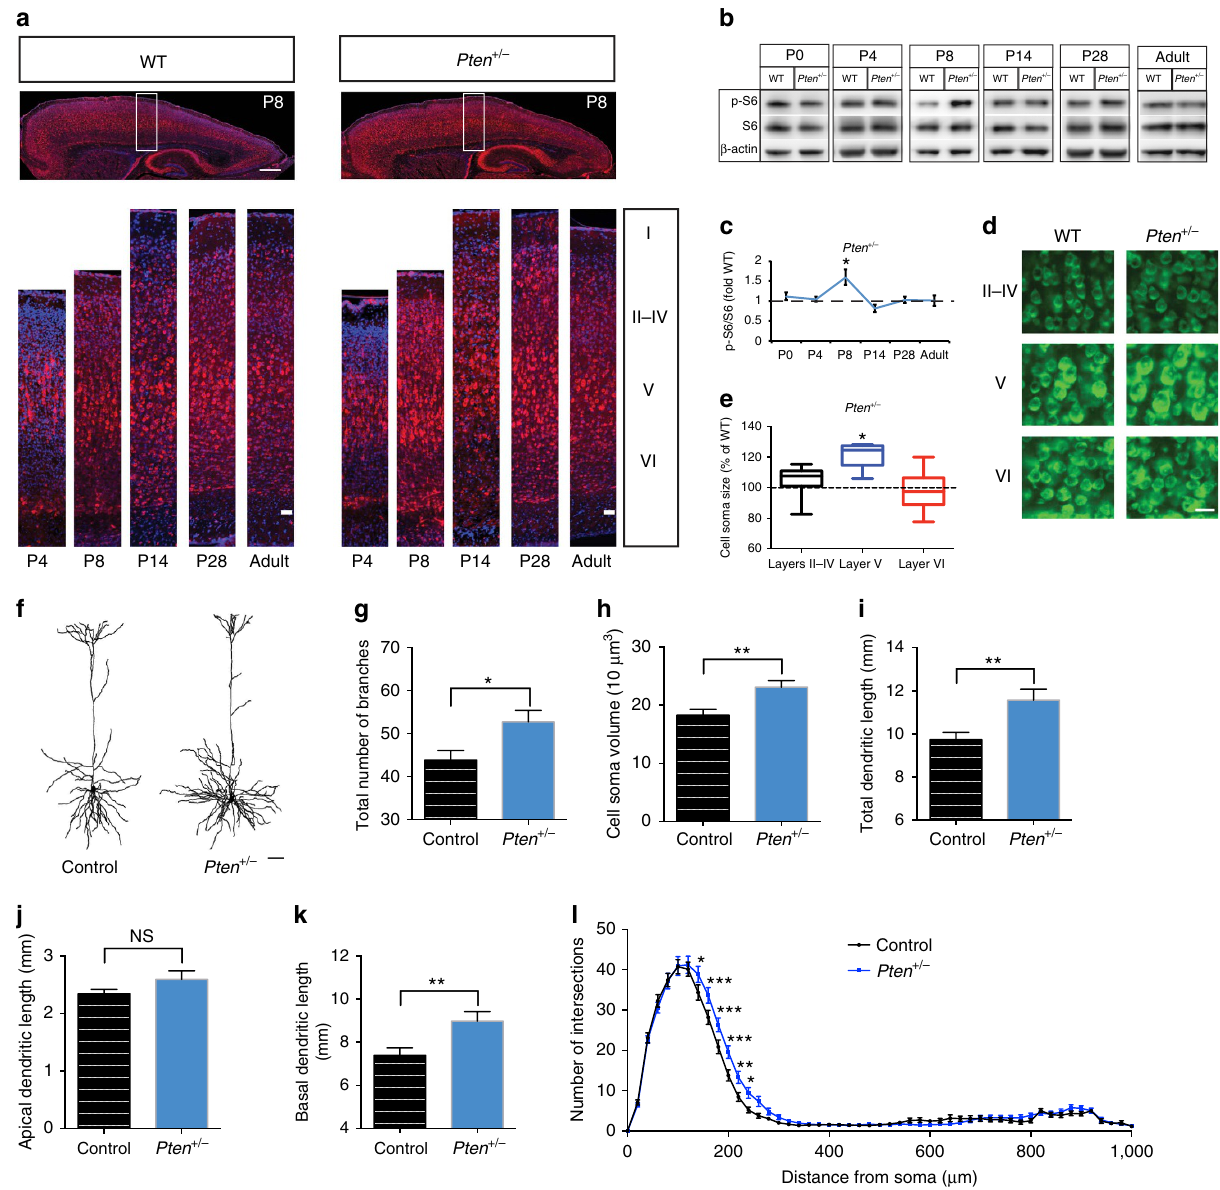
Figure 1 | Characterization of mTORC1 activity and neuronal growth in Pten mutant mice. ( a ) Images showing phospho-S6 (p-S6), a readout for mTORC1 activity, immunostaining in the cerebral cortex of postnatal day 8 (P8) WT and Pten þ / (cid:2) mice. Phospho-S6 (red), DAPI (blue) and scale bar, 500 m m. Representative somatosensory cortex with p-S6 immunostaining in P4, P8, P14, P28, and adult WTand Pten þ / (cid:2) mice. Phospho-S6 (red), DAPI (blue), and scale bar, 50 m m. ( b ) Representative images of western blot for p-S6, total S6 and b -actin in WTand Pten þ / (cid:2) whole cerebral cortex at P0, P4, P8, P14, P28 and adulthood. ( c ) Quantification of p-S6 levels relative to total S6, expressed as fold WT, in the whole cerebral cortex of WT and Pten þ / (cid:2) mice at P0, P4, P8, P14, P28 and adult. Independent-sample t tests were used. * P o 0.05. N ¼ 5 animals per genotype for each time point. ( d ) Representative images of fluorescent Nissl stain in somatosensory cortical layers II–VI of WT and Pten þ / (cid:2) mice at P14. Scale bar, 25 m m. ( e ) Quantification of cell soma size in somatosensory cortical layers II–VI of WT and Pten þ / (cid:2) mice at P14, expressed as per cent of WT. Independent- sample t tests were used. * P o 0.05. N ¼ 6 animals in each genotype. ( f ) Representative images of reconstructed layer V neurons in the somatosensory cortex of P14 Etv1-CreERT2; Ai14 (Control) and Etv1-CreERT2; Ai14; Pten þ / (cid:2) ( Pten þ / (cid:2) ) mice. Scale bar, 50 m m. ( g – k ) Quantification of total number of branches ( g ), cell soma volume ( h ), and total ( i ), apical ( j ) and basal ( k ) dendrite length of layer Vneurons in P14 control and Pten þ / (cid:2) mice. Independent- sample t tests were used. * P o 0.05, and ** P o 0.01 and NS indicates no significant difference. N ¼ 25 neurons/6 animals per genotype. ( l ) Sholl analysis of somatosensory cortex layer V neurons in P14 control and Pten þ / (cid:2) mice. Two-way ANOVA with Bonferroni correction, F (50, 2,448) ¼ 2.174, P o 0.0001 (interaction); * P o 0.05, ** P o 0.01, and *** P o 0.001. N ¼ 25 neurons/6 animals each genotype. All mice used in this figure were male. with lower levels of p-S6 (for example, layers II–IV or VI we detected increased soma size in layer V neurons, but not in neurons) in Pten þ / (cid:2) mice. layers II–IV or VI neurons, in P14 Pten þ / (cid:2) mice as compared with WT mice (Fig. 1d,e). This indicates that the growth of cell As we observed enrichment of p-S6 in developing subcortical- types enriched for p-S6 (for example, layer V neurons), as projecting layer V neurons, amongst other cell types, and we reflected by cell soma size, is desynchronized relative to neurons detected a pronounced change in cell soma size in layer V NATURE COMMUNICATIONS|7:13421|DOI: